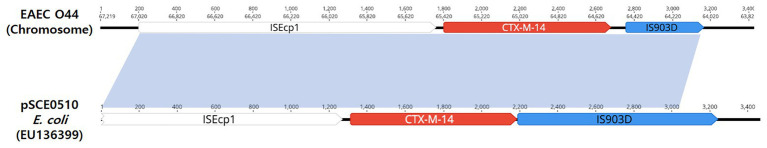
Schematic representation of the genetic environment surrounding the blaCTX-M-14 gene. The hatched box and the arrow indicate the genetic structure ISEcp1-blaCTX-M-14-IS903.